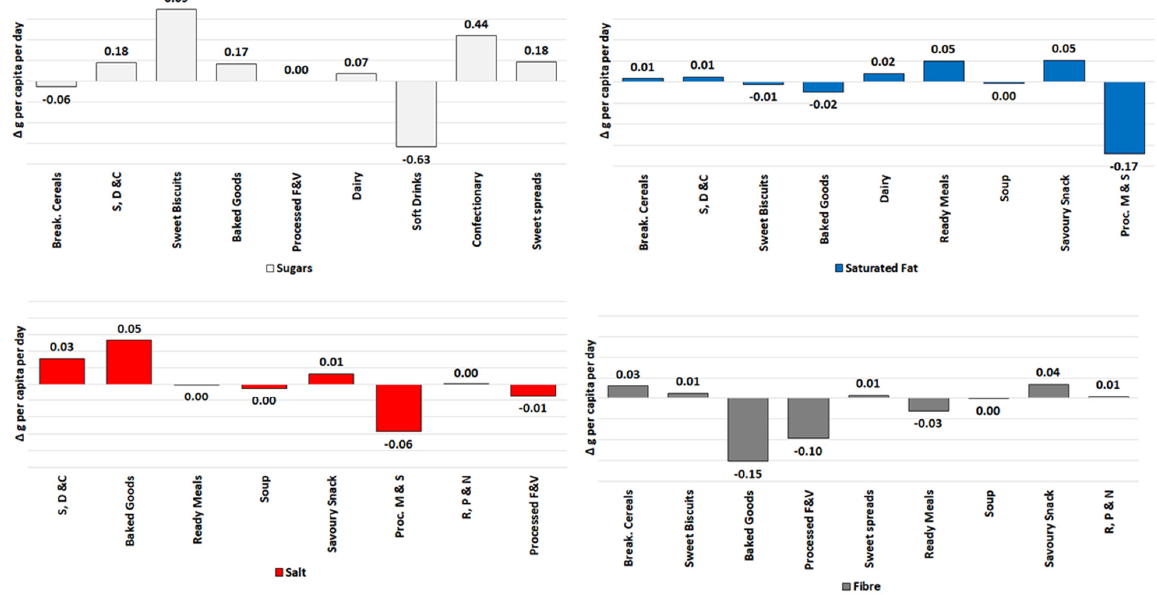
Figure 2. Variations in sales of total sugars, saturated fat, salt and fibre (in g per capita per day) of packaged foods and soft drinks categories in Europe (2015–2018). Source: Elaborated by the authors based on data from Euromonitor (2020) and mid-year population estimates from the HFA-DB. Estimates were scaled by market coverage to represent 100% of the retail market.